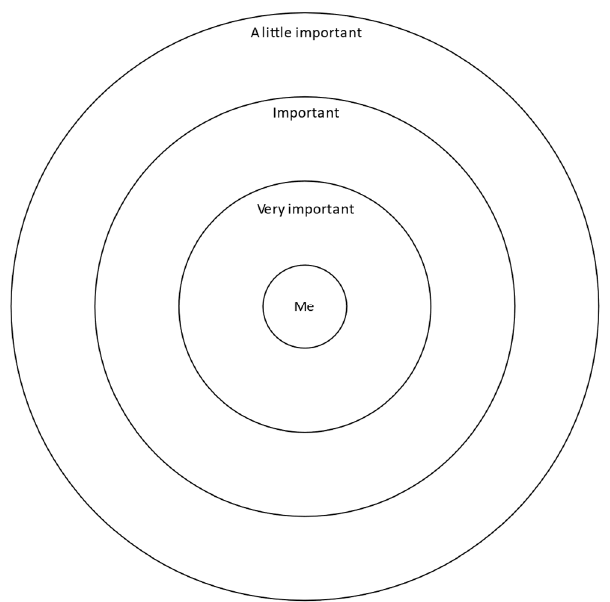
Figure 2. Example of three concentric circles facilitating the Convoy Model derived from Kahn and Antonucci [35].